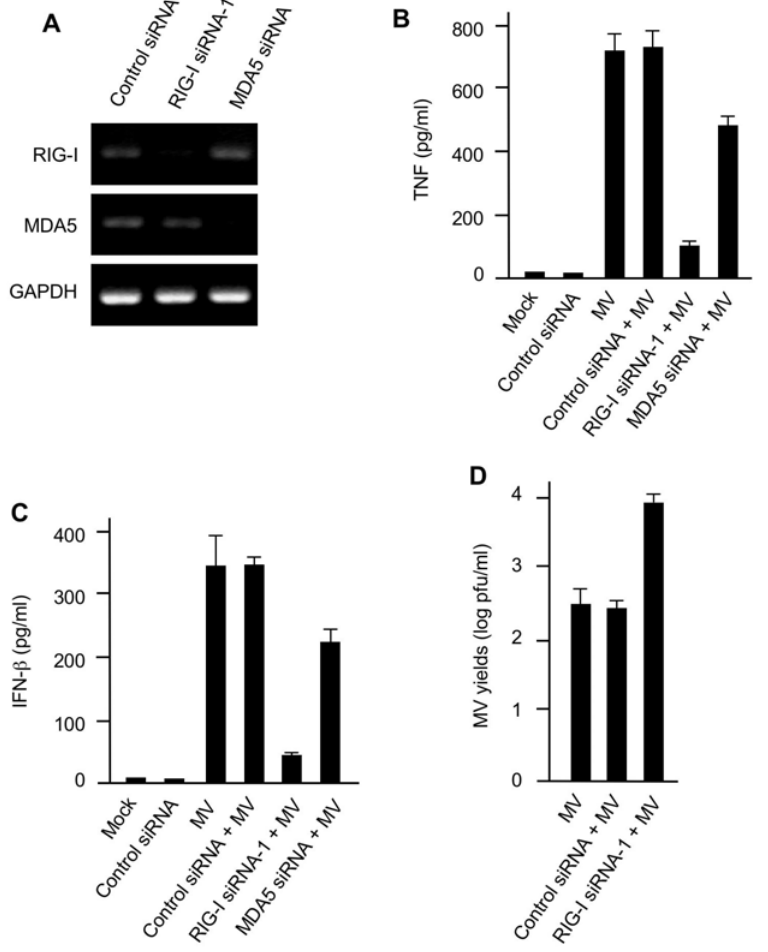
Figure 3. MV-elicited production of TNF and IFN- b is mediated by RIG-I in primary human macrophages. (A) pHMs were transfected with control siRNA or siRNAs targeting cytoplasmic RNA sensors RIG-I (top panel) or MDA5 (middle panel). The cells were analyzed 48 h later by RT- PCR for the indicated mRNA levels. GAPDH was used as control. (B, C) RIG-I is critically required for MV-elicited production of both TNF (B) and IFN- b (C) in pHMs. pHMs or various siRNA pHMs were mock-infected or infected with MV and the accumulation of TNF and IFN- b in the culture supernatants was assessed by ELISA 24 h post-infection. (D) RIG-I mediates cellular restriction to MV infection in pHMs. pHMs or control siRNA or RIG-I siRNA pHMs as indicated were infected with MV. MV yields were determined by the standard plaque assay using BGMK cells at 48 h after infection. Data in (B), (C) and (D) represent mean + / 2 SD.